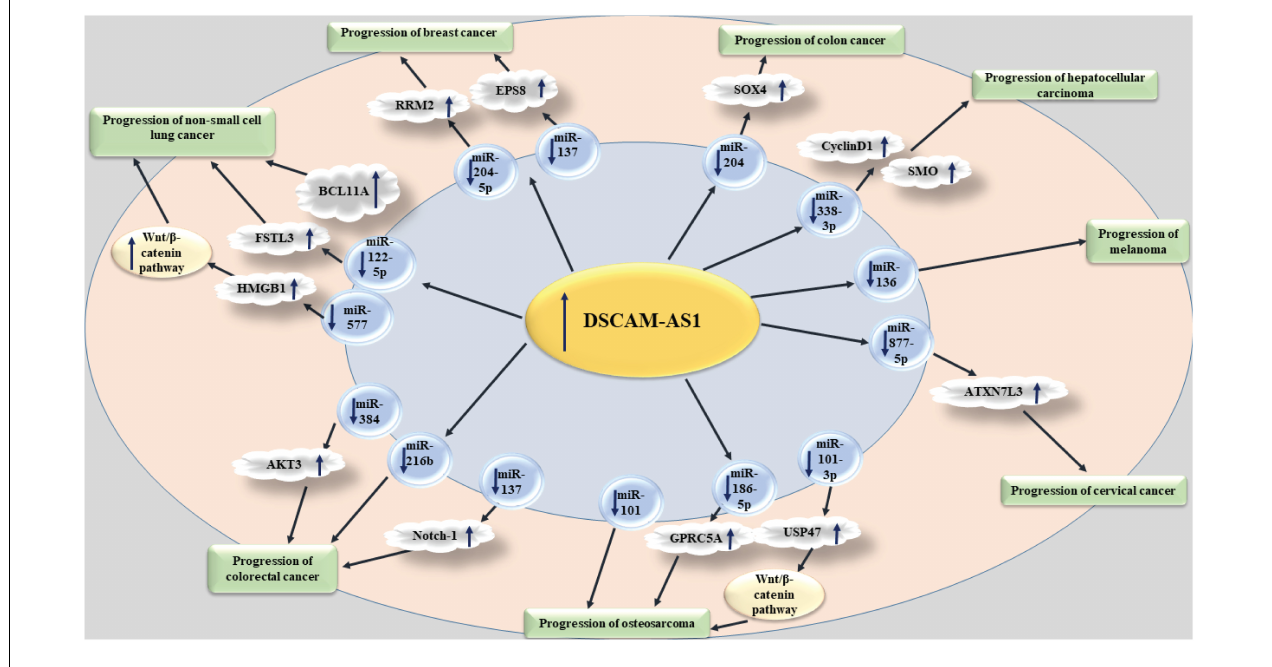
FIGURE 1 | The effects of DSCAM-AS1 in different types of